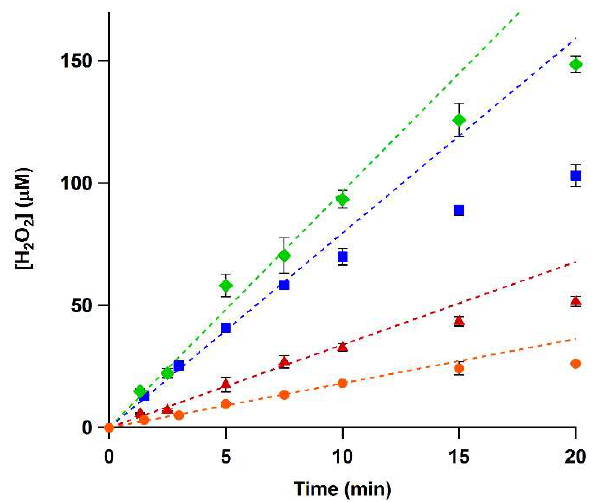
Figure 1. Conversion of eugenol or vanillyl alcohol by His-tagged vanillyl alcohol oxidase (His-VAO) or His-tagged eugenol oxidase (EUGO-His) followed in time using the xylenol orange assay. His-VAO ([●] for vanillyl alcohol, [ ♦ ] for eugenol) or EUGO-His ([ ■ ] for vanillyl alcohol, [ ▲ ] for eugenol) was incubated with 2 mM substrate in 50 mM potassium phosphate buffer, pH 7.5, at room temperature (19–20 °C). Reactions were allowed to proceed for the specified time, after which the amount of hydrogen peroxide formed was determined using the xylenol orange assay. Error bars represent the standard deviation of triplicate measurements. Broken lines are fits to the linear range of the data that were used to determine reaction rates (see Table 2).